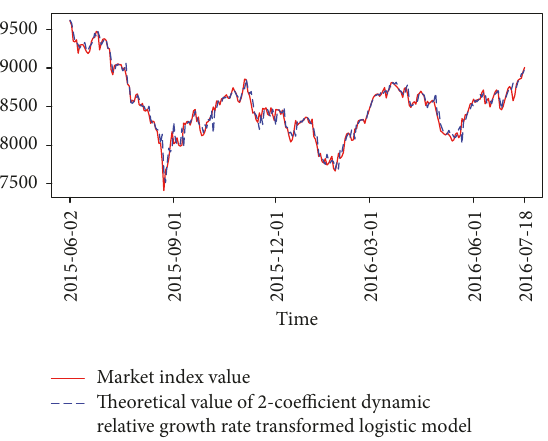
Figure 3: Time plot of raw data and model C fits.